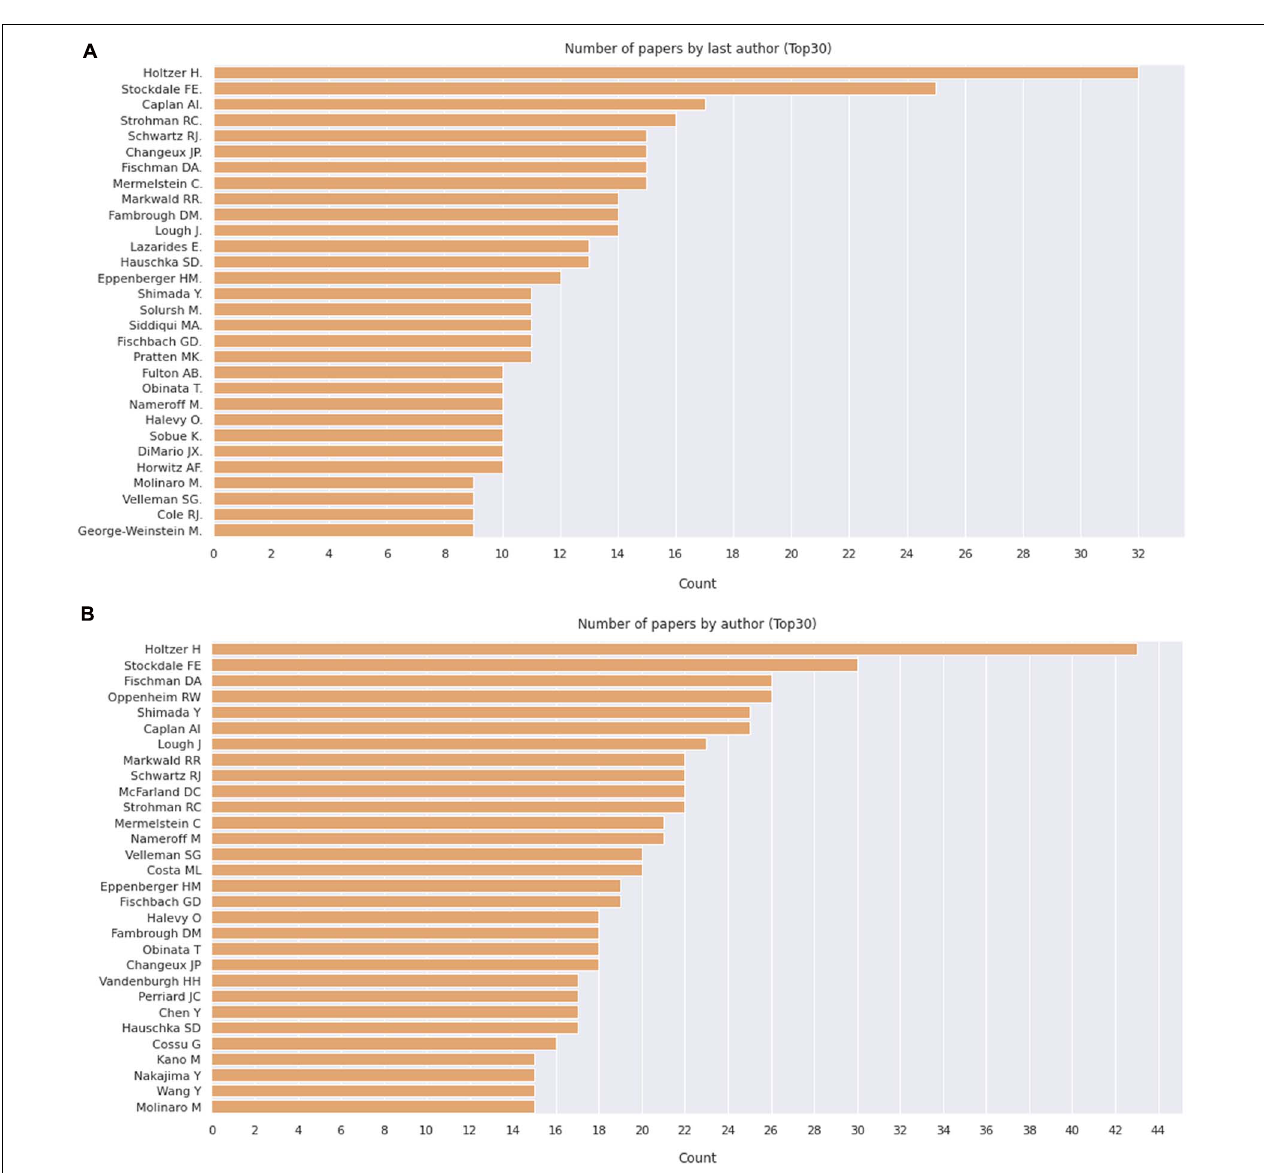
FIGURE 7 | Number of apers by last author. (A) Number of papers by journal, as indicated. (B) Pie chart depicting the relative proportion of journals grouped by the number of published papers on the subject. The retrieved PubMed dataset only included papers until the year of